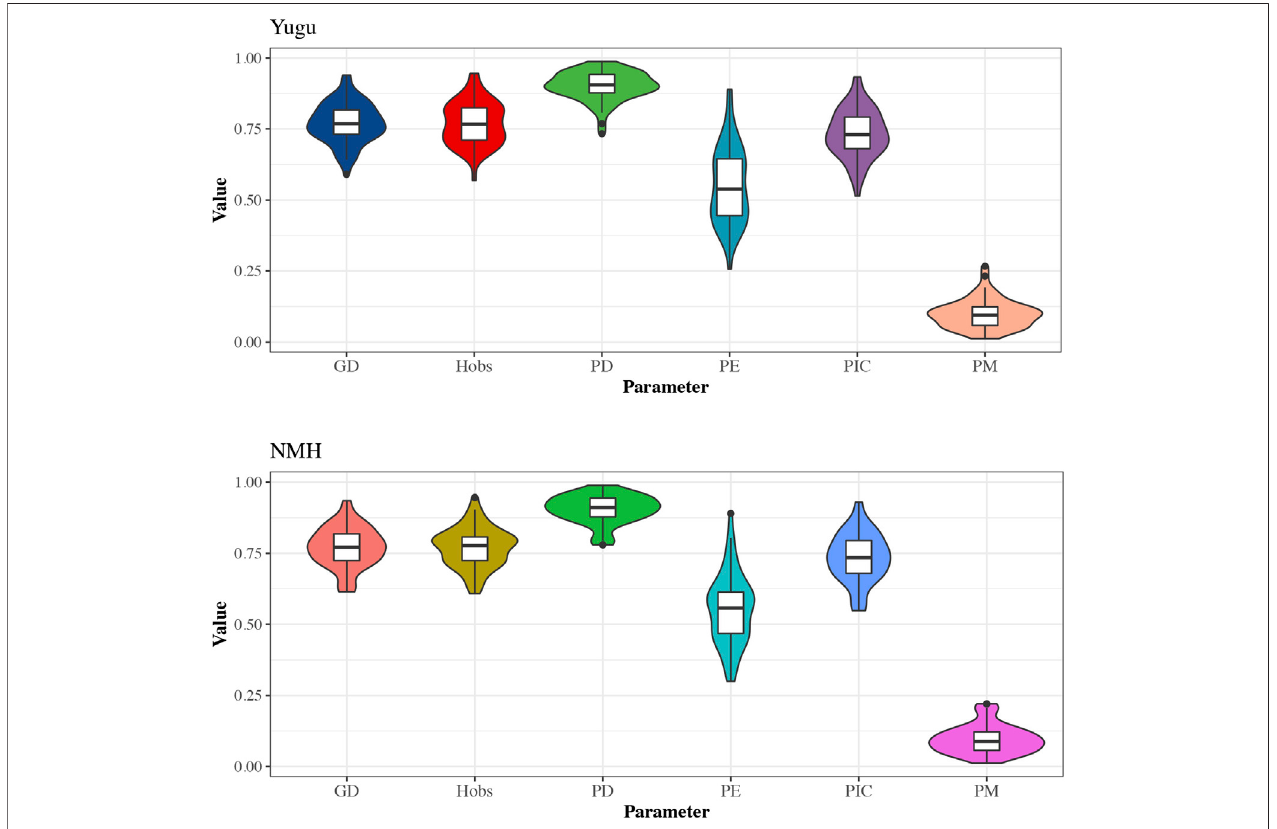
FIGURE1| Theviolinplotoftheforensicdescriptiveparametersfor54A-STRsintheYuguandNMHpopulations.Theupperandloweredgesoftheboxrepresent the upper and lower quartiles of data, respectively, and the box contains 50% of the data. The scattered points outside the box represent outliers.